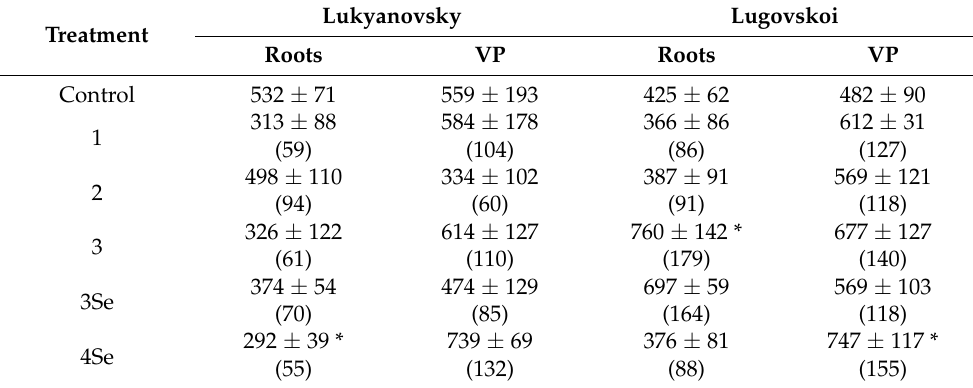
Table 2. Biomass (mg) of roots and vegetative part (VP) of in vitro plants of Lukyanovsky and Lugovskoi potato cultivars in control and after 28 days of treatment by fungal biopreparations without Se based on Grifola umbellata (1), Ganoderma lucidum 1315 (2), Pleurotus ostreatus (3), and by fungal bio-composites with Se based on P. ostreatus (3Se), G. lucidum SIE1303 (4Se) (percent to control in parentheses). Lukyanovsky Treatment